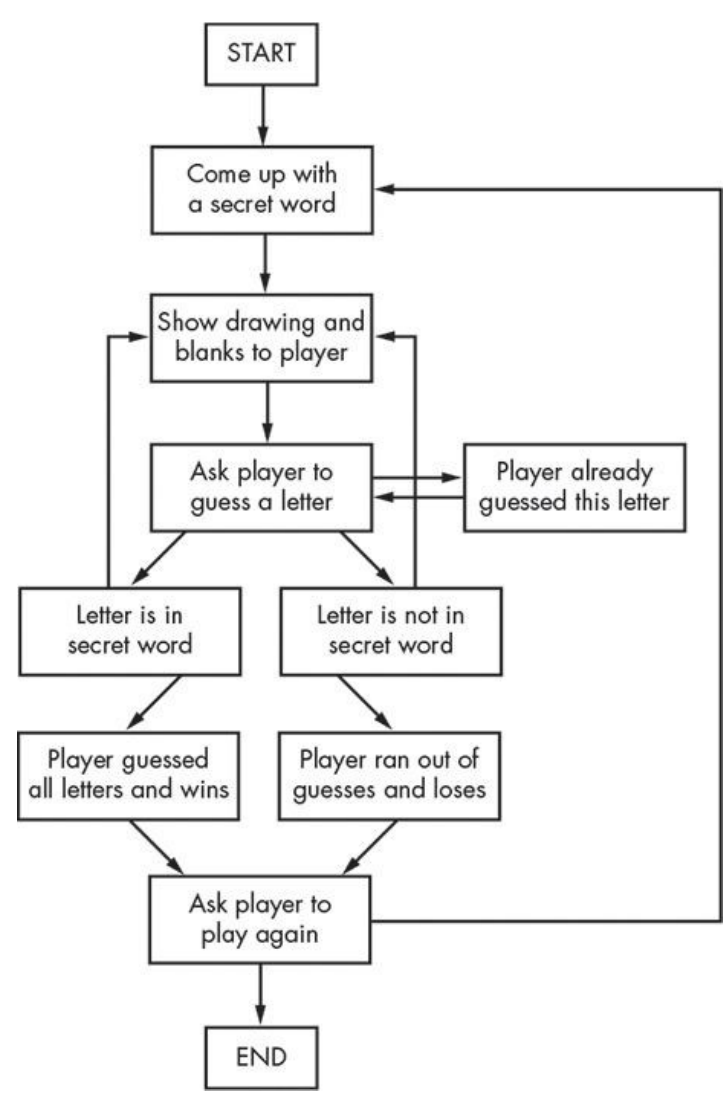
Fig. 2 Flowchart of the GA-MAS algorithm. GA-MAS, genetic algorithm multi-agent